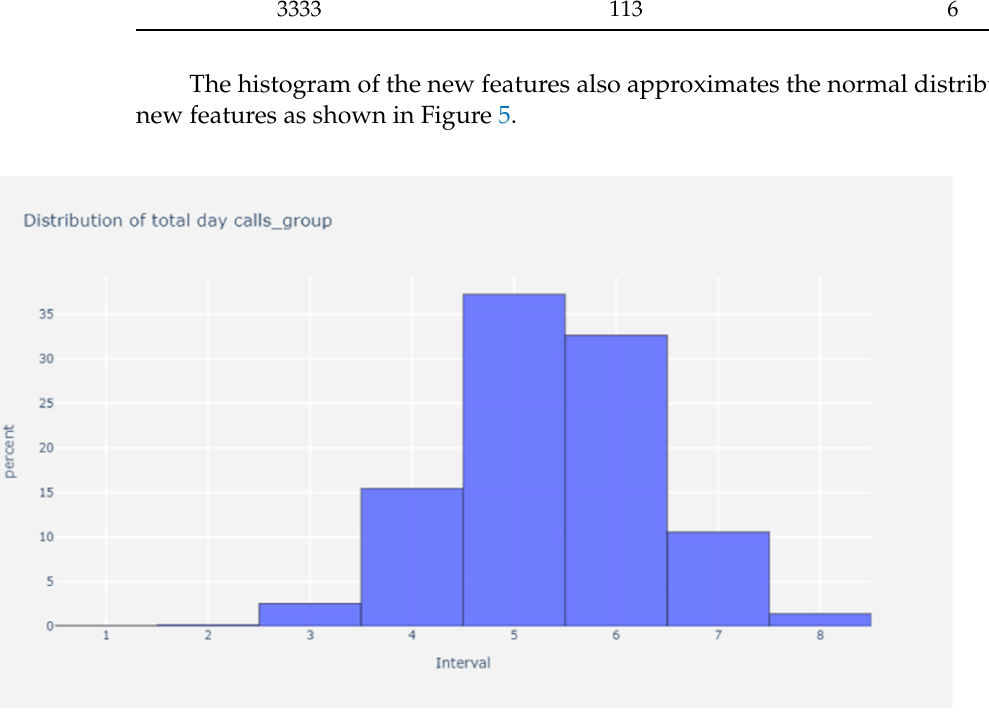
Figure 5. Histogram for the new feature ’total day calls group’.